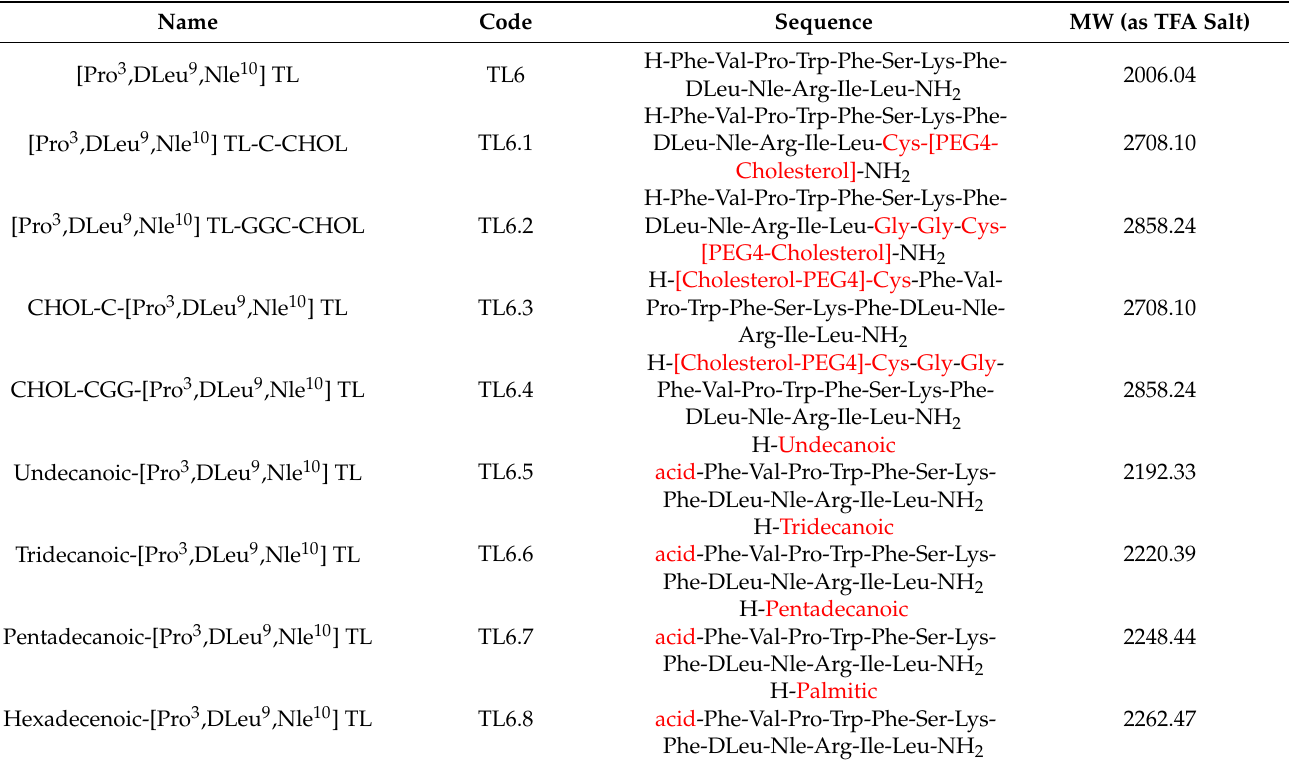
Table 5. Names, codes, sequences, and molecular weight of TL6 and its